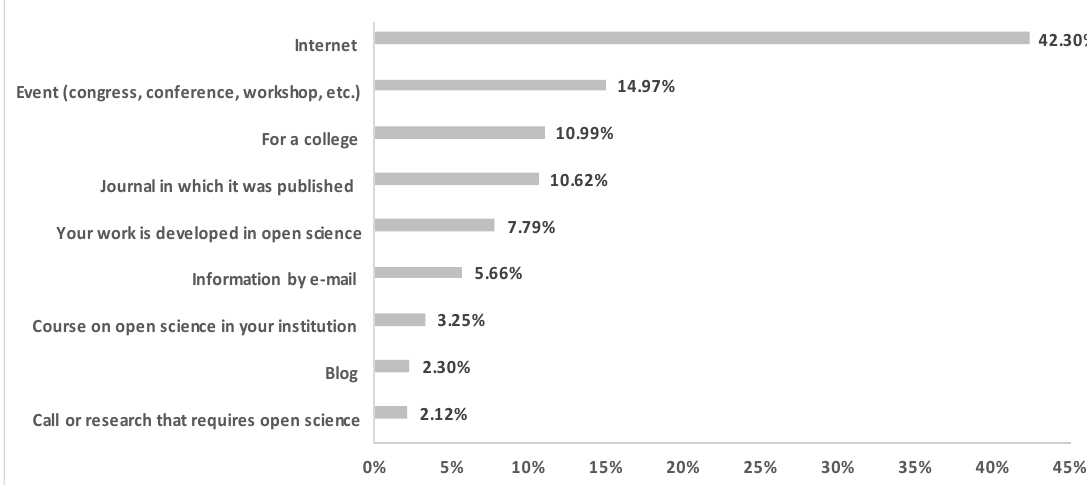
Figure 4. The main media platforms used by Colombian researchers to find information about open science.